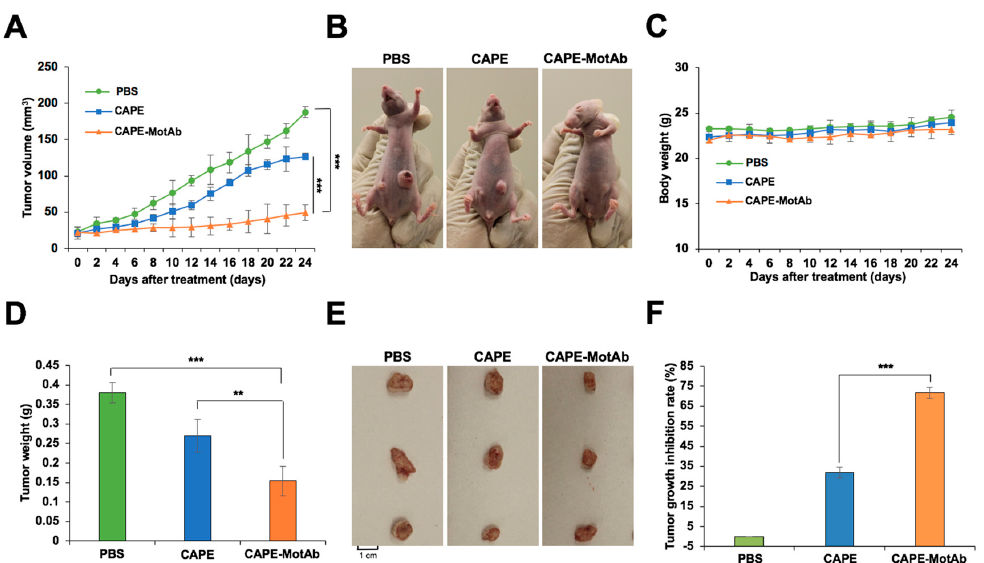
Figure 7. Enhanced selective tumor-suppression activity of CAPE-MotAb in in vivo conditions. ( A ) Relative tumor volumes of A549 cells in the control, CAPE, and CAPE-MotAb treated mice (mean ± SD, n = 4), *** p < 0.001 (Student’s t-test). The tumor-forming ability in nude mice bearing A549 xenografts treated by CAPE-MotAb was significantly decreased when compared to control and CAPE treated groups. ( B ) Images showing a greater reduction in tumor volume after treatment with CAPE- MotAb compared to the other two groups. ( C ) No significant changes in body weight were observed during the treatment period. The average weights ( D ) and images ( E ) of A549 xenograft tumors at the experiment endpoint (mean ± SD, n = 4), ** p < 0.01, *** p < 0.001 (Student’s t-test). ( F ) Tumor growth inhibition rate following treatment with CAPE and CAPE-MotAb in A549 xenografts (mean ± SD, n = 4), *** p < 0.001 (Student’s t-test). All the formulations were administered intraperitoneally with an equivalent dose of CAPE (200 mg / Kg / 2